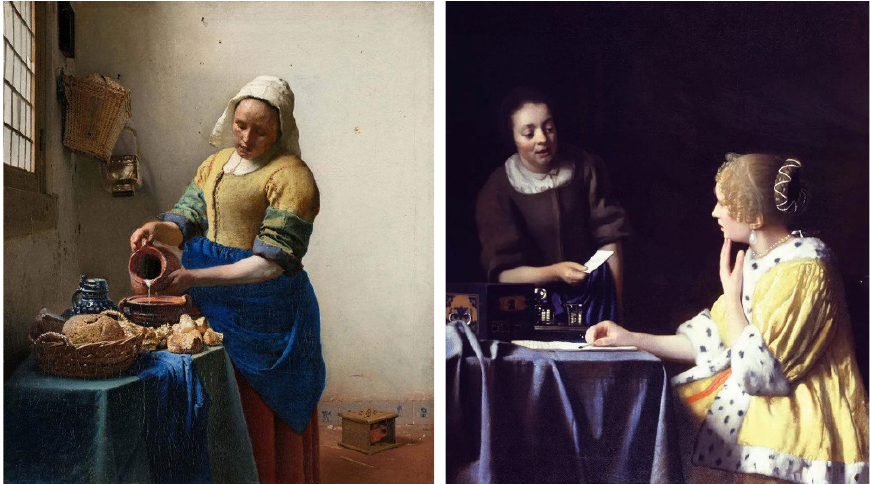
Figure 1. Experimental material picture. ( Left picture: The Maid Pouring Milk represents an isolated individual scene. Right picture: A Lady and Her Maid represents a social interaction scene).